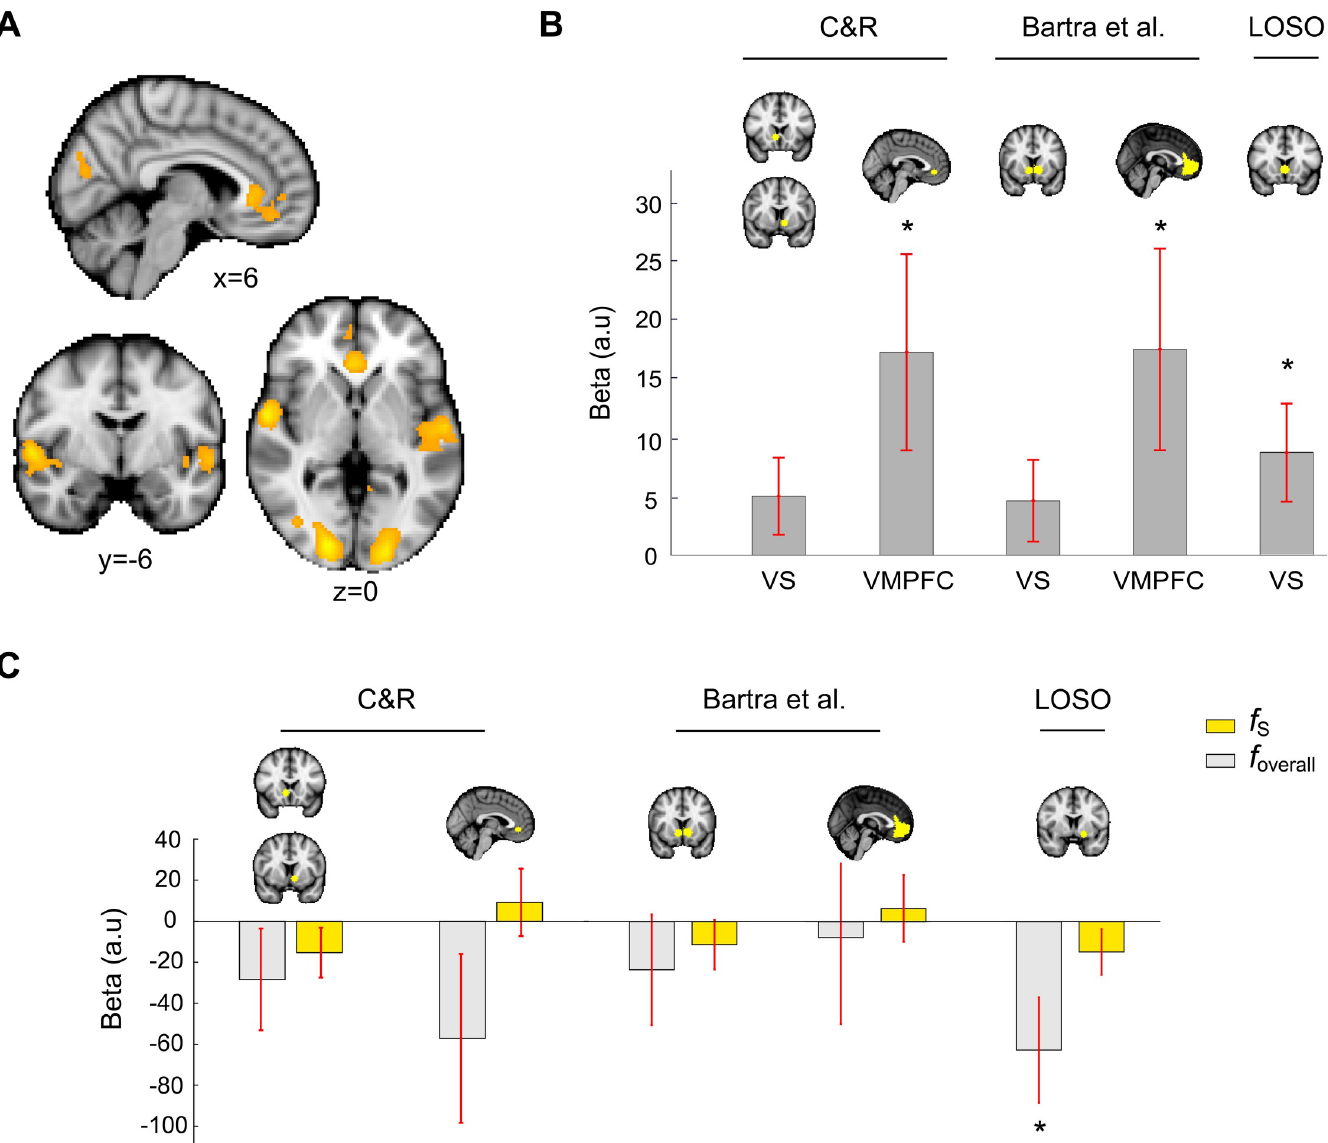
Fig 10. Univariate GLM results replicating reward magnitude and reward prediction error representations in VMPFC and VS and showing significant reward- frequency representation in VS. (A) Neural correlates of reward magnitude at the time of reward feedback. Cluster-level inference using Gaussian random field theory was performed (familywise error corrected at p < 0.05) with a p < 0.001 cluster-forming threshold. (B) ROI analysis on reward prediction error. We used VMPFC and VS ROIs from two meta-analysis papers on value-based decision making ([26]: shown as Bartra and colleagues; [27] shown as C&R) and VS ROI identified through LOSO method based on reward prediction error contrast at the time of reward feedback. (C) ROI analysis on frequency of reward associated with stimulus ( f overall reward frequency associated with a context ( f overall ). � p < 0.05. Data underlying these graphs can be found in https://osf.io/48j7m. GLM, general linear model; LOSO, leave one subject out; ROI, region of interest; VMPFC, ventromedial prefrontal cortex; VS, ventral striatum.